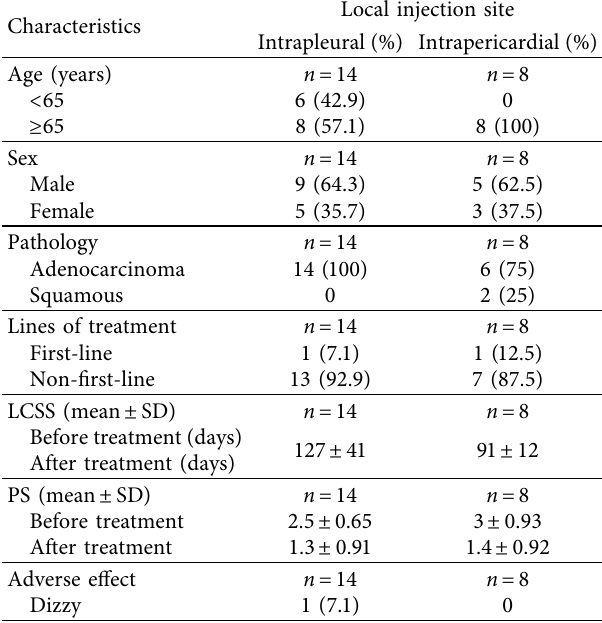
Table 1: Patient characteristics. Local injection site Characteristics